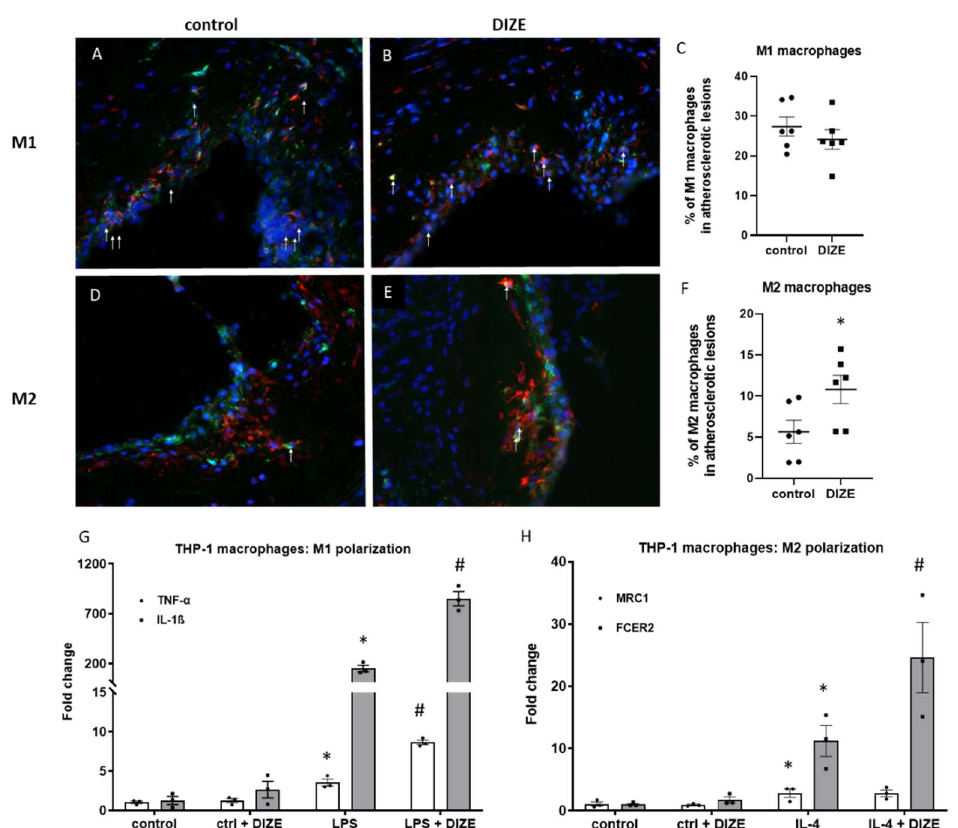
Figure 3. Macrophages polarization in atherosclerotic lesions and THP-1 cell culture after treatment with DIZE. Representative immunohistochemical staining of aortic roots showing F4/80 (green), nitric oxide synthase 2 (iNOS)/arginase 1 (red), and 4′6-diamidino-2-phenylindole (DAPI) (blue) co-localization in control ( A , D ) and DIZE-treated mice ( B , E ). White arrows indicate M1 ( A , B ) and M2 ( D , E ) macrophages, respectively. Quantitative analysis of M1 and M2 contents in the atherosclerotic plaques ( C , F ). mRNA expression of M1 (IL-1 β and TNF- α ) ( G ) and M2 (MRC1, FCER2) ( H ) markers in THP-1 macrophages cell culture polarized to proinflammatory M1 and anti-inflammatory M2 phenotype after treatment with DIZE. Data are mean ± SEM analyzed using t -test ( C , F ) or one-way ANOVA with multiple comparisons and Benjamini and Hochberg false discovery rate (FDR) correction ( G , H ) (* p < 0.05 as compared to control; # p < 0.05 as compared to LPS or IL-4, respectively; n = 3 independent experiments or n = 6 biological replicates per